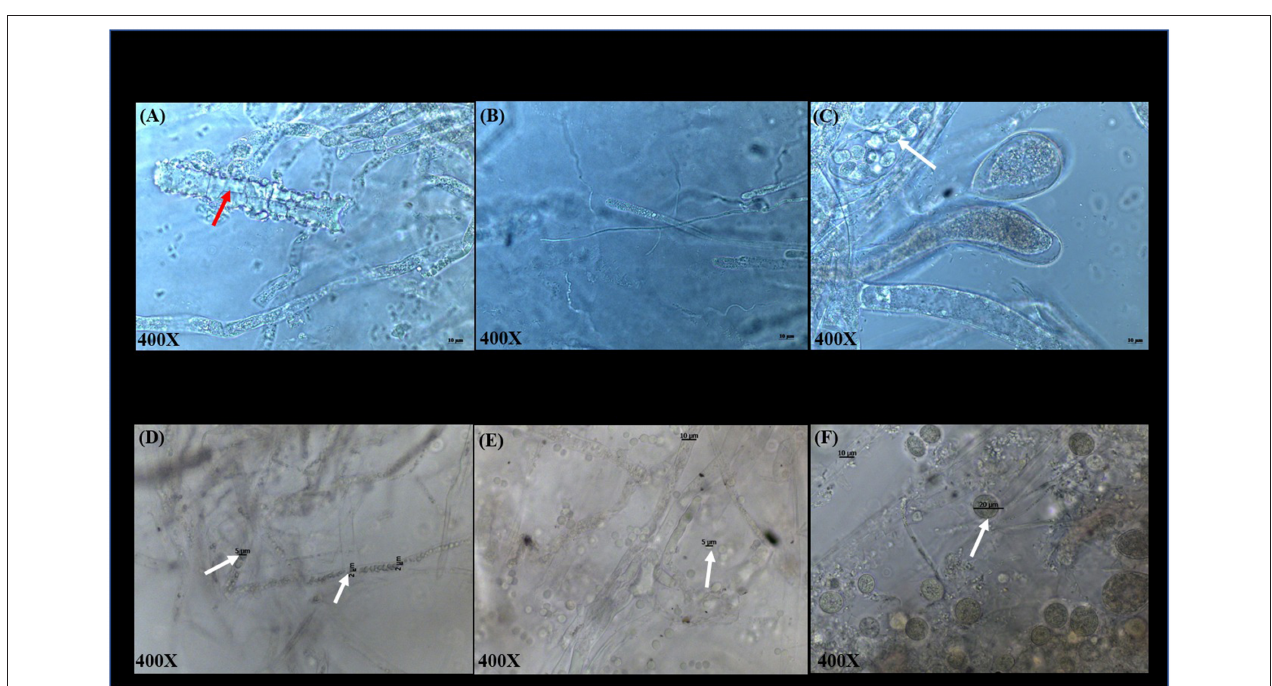
FIGURE 4 | Microscopic observations of S. parasitica after treating tanks with different quantities of COPPERWARE ® (L-copperware: 7.5 × 3.7 × 2.4cm, 9.46g; M-copperware: 7.5 × 3.7 × 1.2cm, 4.96g; S-copperware: 3.75 × 3.7 × 1.2cm, 2.58g) and commercial filter with no CCCSNs (No-copperware) in experiment 1 at 72h (A–C) and experiment 2 at 144h (D–F) . red arrow: damaged hyphae; White arrow: spores. The spore size in (D) : 2–5 µ m; The spore size in (E) : around 5 µ m; The spore size in (F) : around 20 µ m.